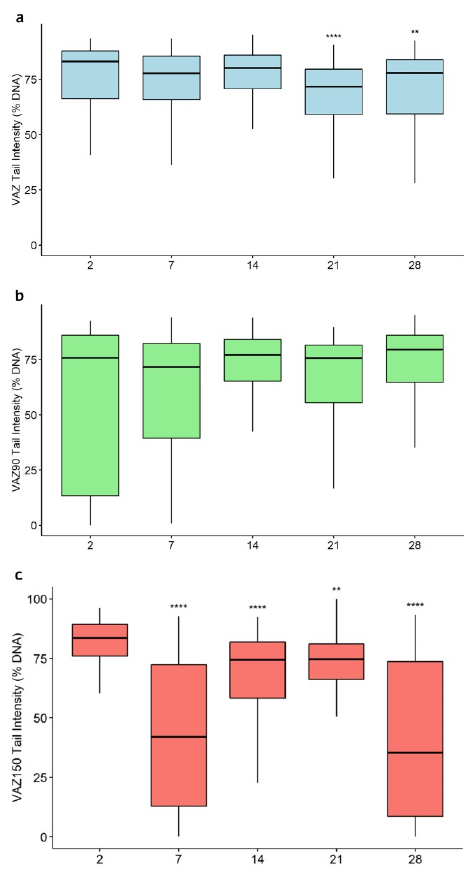
Figure 10. Tail Intensity in earthworms coelomocytes. ( a ) Trial at the field copper concentration (VAZ), ( b ) trial at the fortified copper concentration of 90 mg/kg (VAZ90), and ( c ) trial at the fortified copper concentration of 150 mg/kg (VAZ150). According to Dunn’s test, asterisks relate to significant differences of each time compared to day 2 from contamination (** p < 0.01; **** p < 0.0001). At the field concentration (VAZ), the DNA damage showed a decreasing trend over time with respect to the damage on day 2 (TI values of 83%), reaching TI values signifi- cantly different from 72% and 78% on days 21 and 28, respectively. In the VAZ90 treat- ment, no significant differences were found between the damage on days 7, 14, 21, and 28 and the initial damage on day 2. An evident and significant trend of decrease in DNA damage indexes was observed in the thesis with the highest Cu concentration (VAZ150); indeed, despite the fluctuation measured at 14 and 21 days, the DNA damage always remained significantly lower with respect to that observed on day 2. Table 4 reports the median Tail Intensity values and the differences in DNA damage at the five sampling times between the test at field Cu concentration (VAZ) and those at 90 and 150 mg/kg (VAZ90 and VAZ150). The comparison showed that at the higher dose of copper, from 7 days onwards, significantly lower DNA damage indexes were recorded except for day 21. On the contrary, the damage levels measured in VAZ90 are similar to those measured in the coelomocytes analysed in the earthworms maintained at the field dose (VAZ).